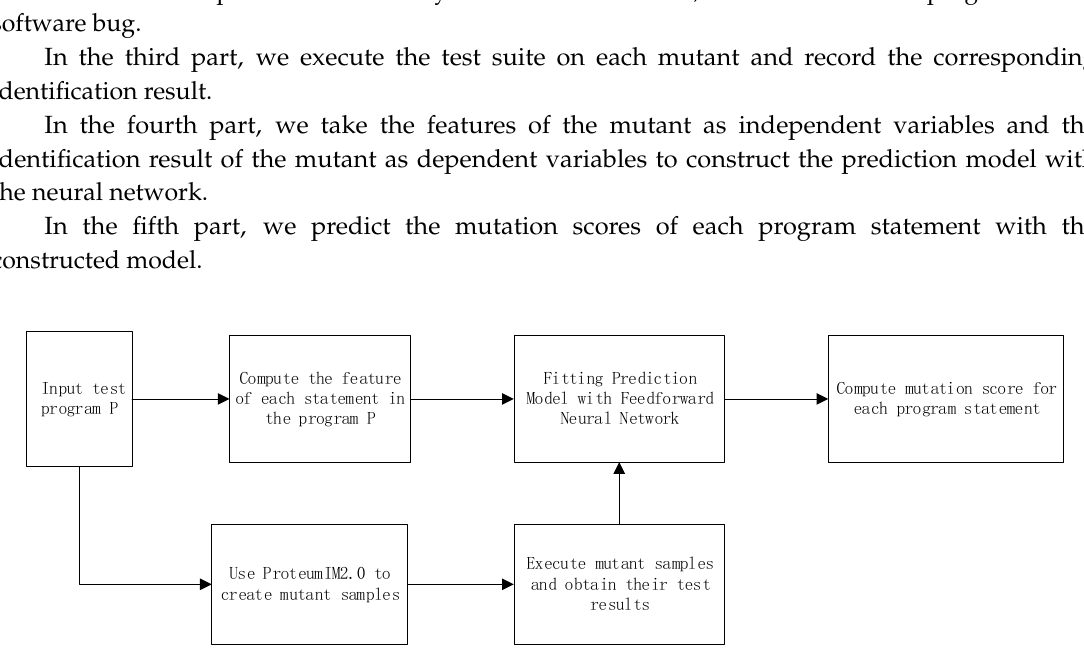
Figure 12. The structure of Automated Analysis